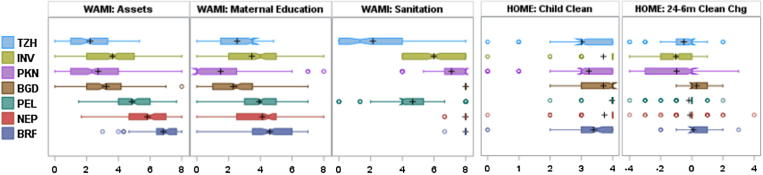
Distribution of WAMI component and HOME Cleanliness scores by site. Sites are sorted by highest to lowest overall WAMI score. Symbol descriptions: the box represents the Interquartile Range (25th to 75th percentile); the black plus (+) is the mean; the median is indicated by the box notch; lines extending from the box with hash marks are 1.5 times the interquartile values; and circles represent potential outliers.